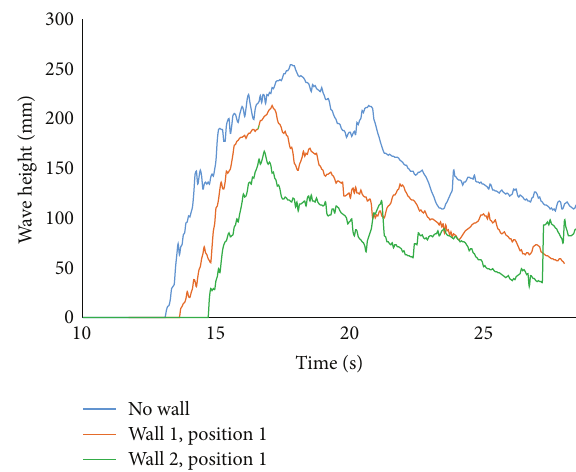
Figure 2: Time series of wave height for wall 1 and wall 2 in position 1 ( 𝑥 = 3.75 m from the